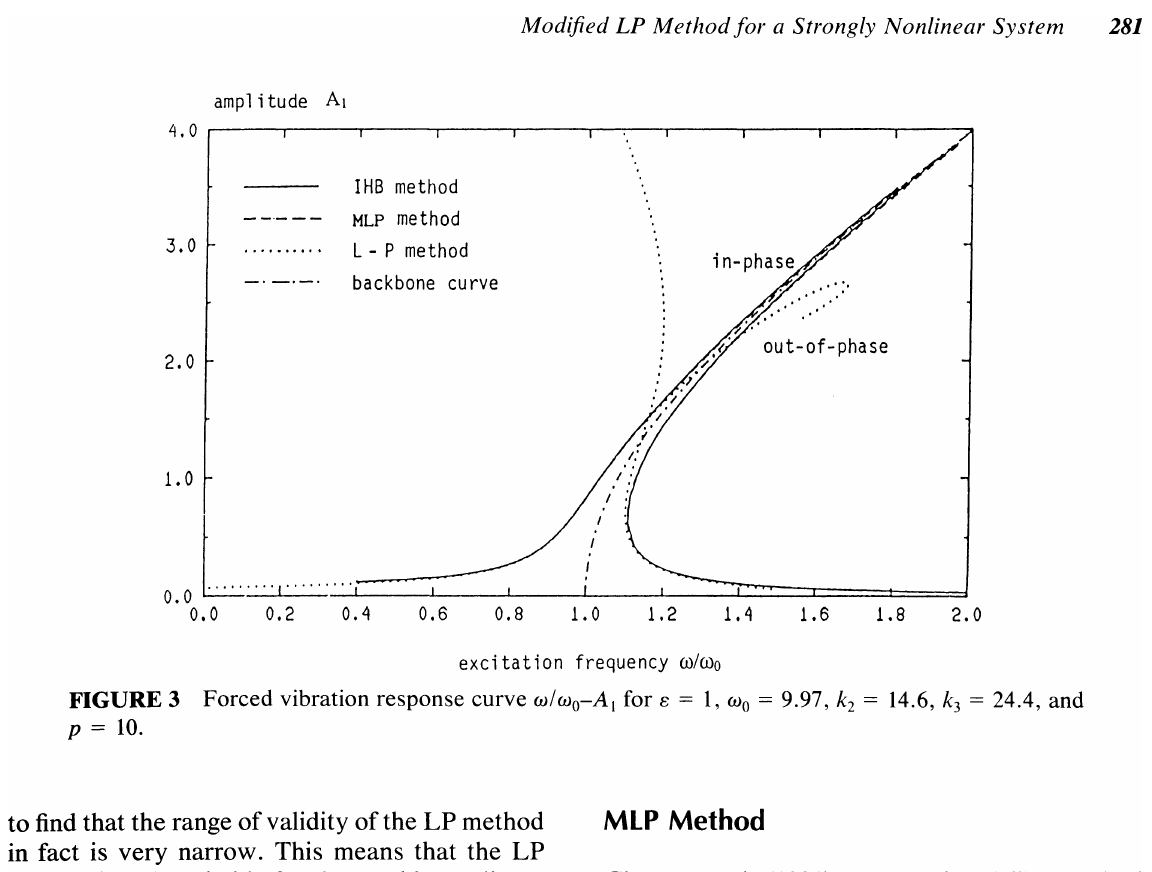
FIGURE 3 Forced vibration response curve wlwo-AJ for e = 1, Wo = 9.97, k2 = 14.6, k3 = 24.4, and p = 10.